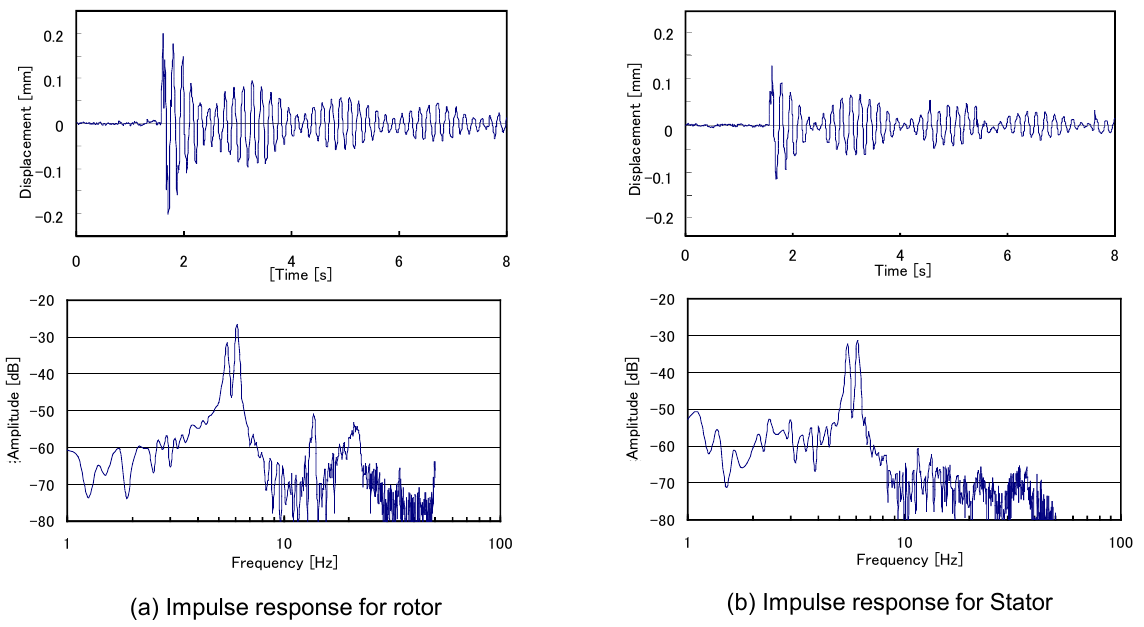
Figure 13. Impulse responses for ( a ) the rotor at a center position of the rotor in the case of an unfixed stator and for ( b ) the unfixed stator at just the upper position of the rotor, representing that the upper and lower figures show a displacement and power spectrum, respectively.